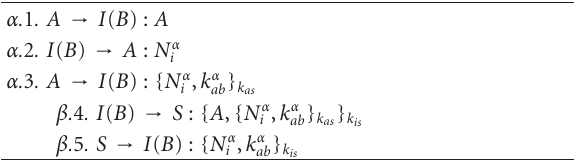
Table 3: Woo and Lam modified protocol. Table 4: Valid trace for the Woo and Lam modified protocol.